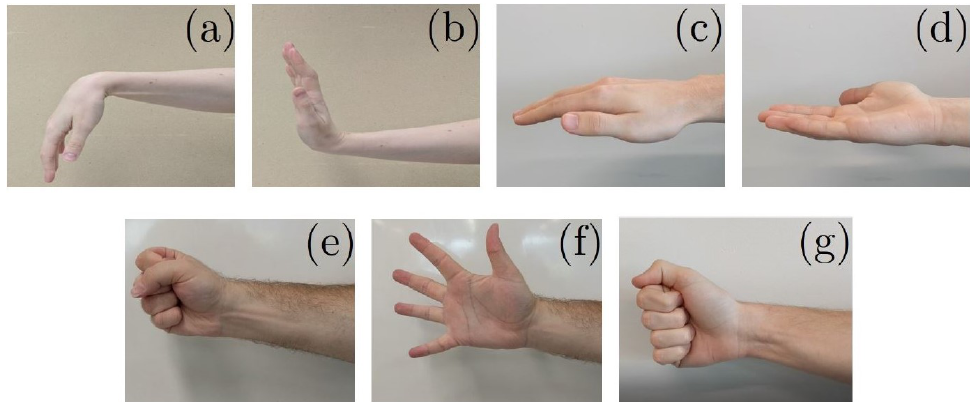
Figure 2. Wrist and finger motions that were recorded. ( a ) Wrist Flexion (WF). ( b ) Wrist Extension (WE). ( c ) Wrist Pronation (WP). ( d ) Wrist Supination (WS). ( e ) Hand Closed (HC). ( f ) Hand Open (HO). ( g ) Key Pinch (KP).